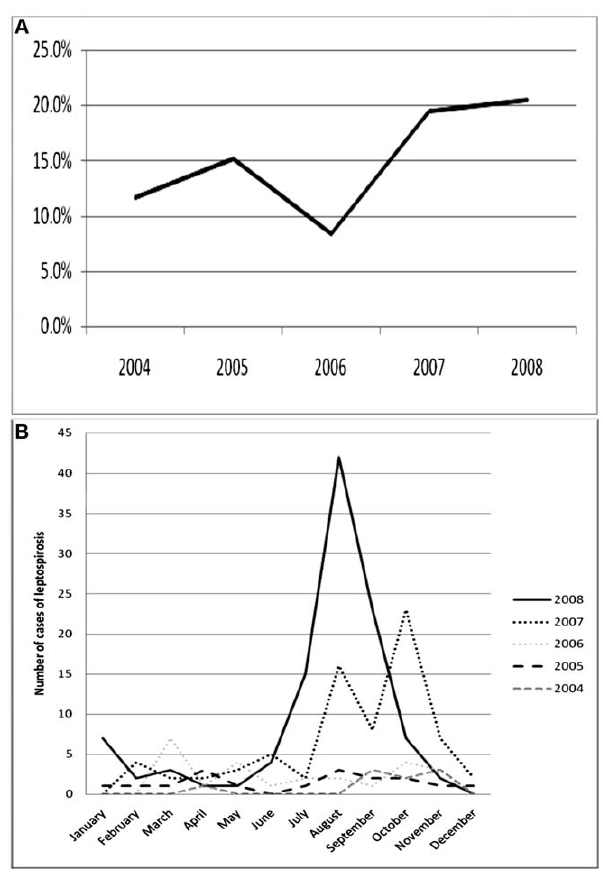
Figure 1. Time trends in leptospirosis. (A) Percentage of leptospirosis patients among those with acute febrile illnesses. (B) Month- and year-wise distribution of cases. * Total number of leptospirosis patients was 232 (9 in 2004, 17 in 2005, 25 in 2006, 74 in 2007, and 107 in 2008).